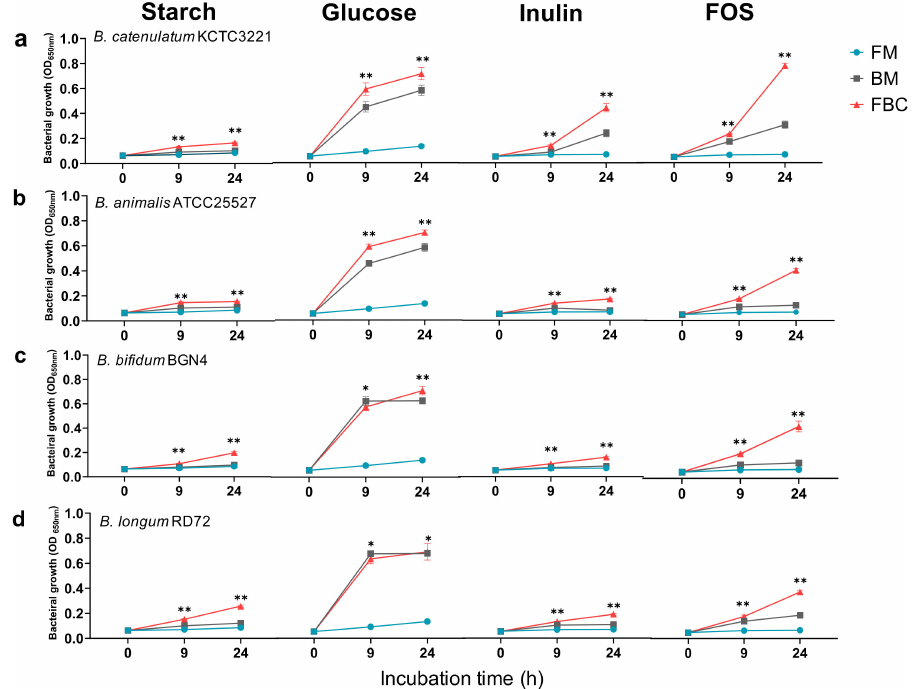
Figure 1. Growth of F. prausnitzii ATCC 27768 with di ff erent Bifidobacterium species in liquid culture in the presence of various carbohydrates. Culture OD 650 was determined at various time points after inoculation. F. prausnitzii growth in monoculture and co-culture with B. catenulatum KCTC 3221 ( a ), B. animalis ATCC 25527 ( b ), B. bifidum BGN4 ( c ), and B. longum RD72 ( d ) is shown. All